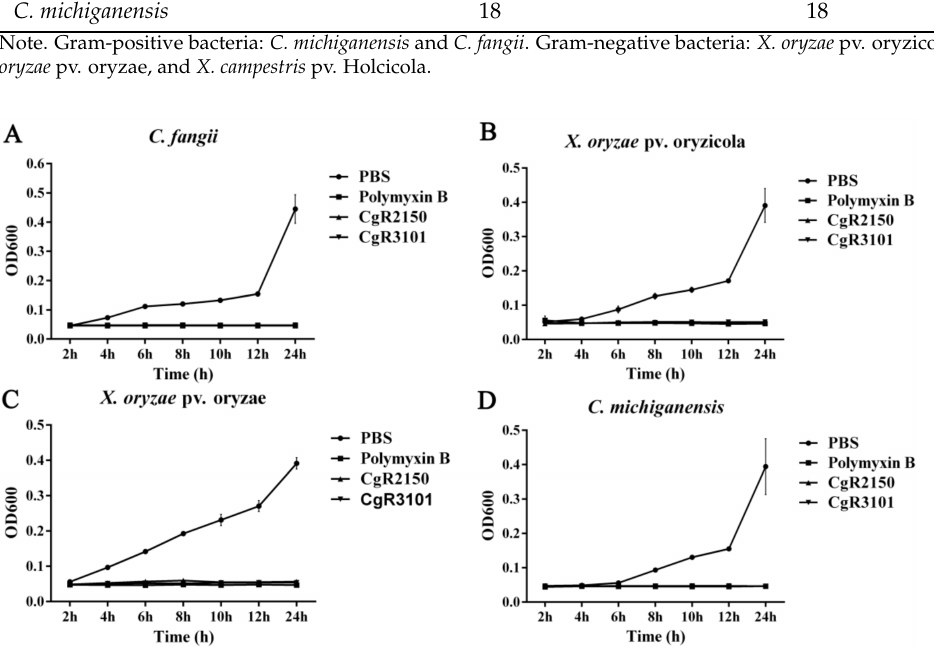
Figure 10. Time-kill curve of CgR2150 and CgR3101. The inhibitory effects of CgR2150 and CgR3101 on bacteria were demonstrated by bacterial growth curves. Among them, PBS buffer treatment was used as a negative control, and polymyxin B treatment was used as a positive control. ( A ) C. fangii , ( B ) X. oryzae pv. oryzicola, ( C ) X. oryzae pv. oryzae, and ( D ) C. michiganensis are time-kill kinetics by CgR2150 and CgR3101 at their MICs. The data are the mean values obtained after three independent experiments, and the vertical bars are the standard deviations